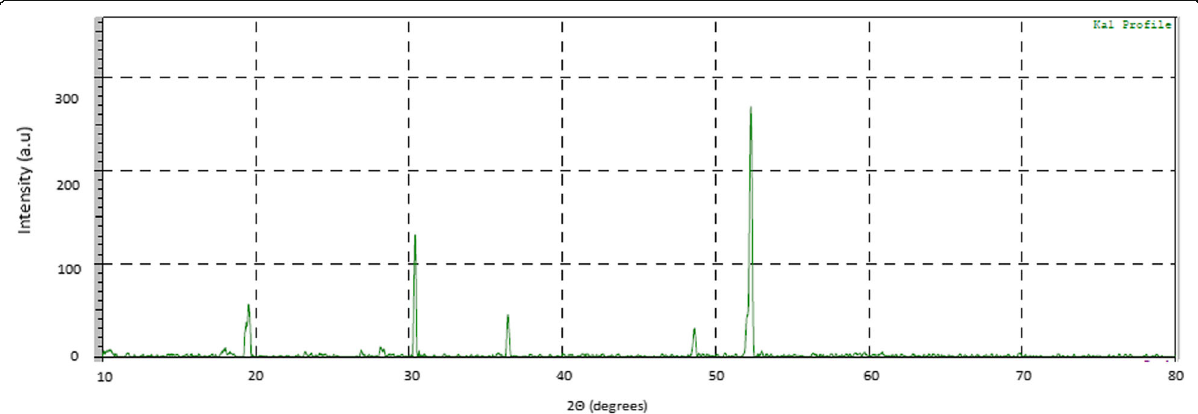
Fig. 9 XRD scan of crystals formed by 0.218 g/ml of solute in acetone obtained by solvent evaporation method for 24 h with 100 rpm stir